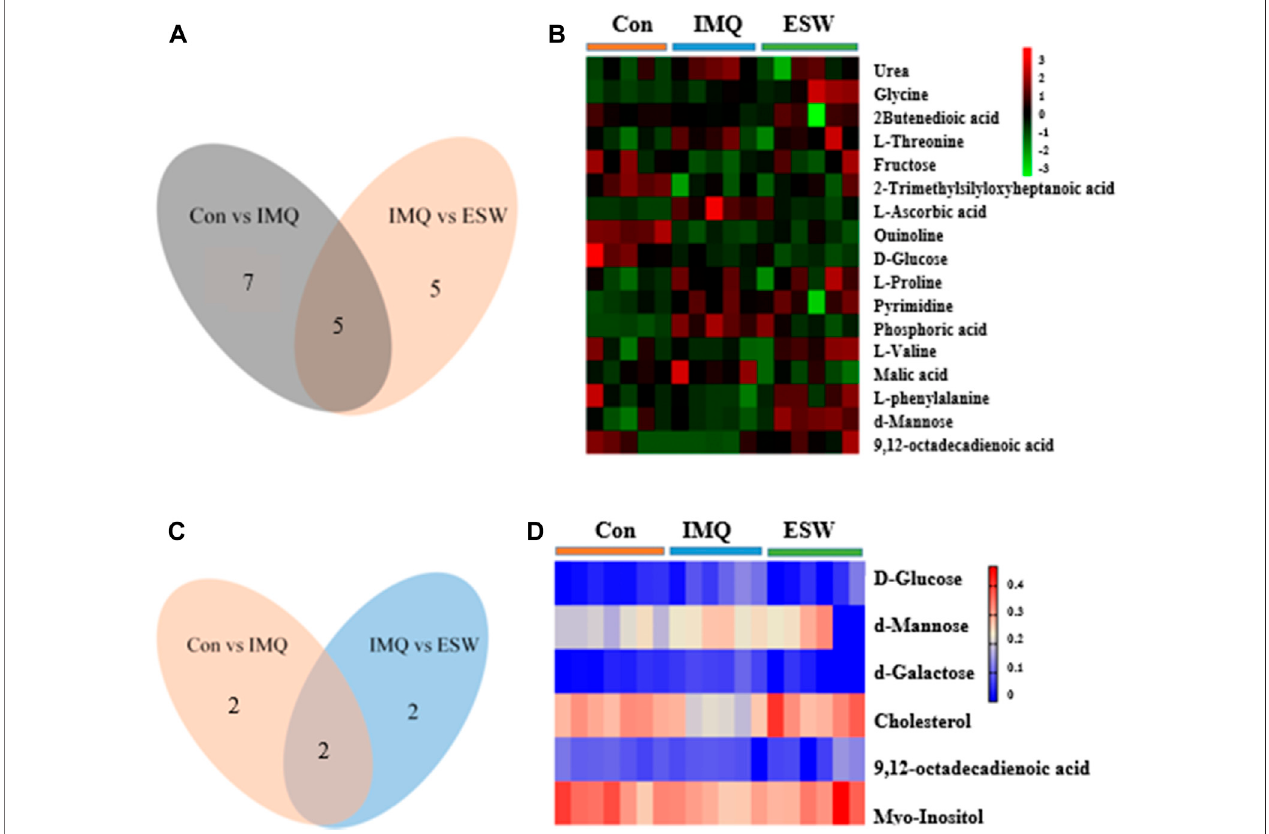
FIGURE 8 | Venn diagram of the signi fi cant differential metabolites and heatmap of differential metabolites in the spleen (A , B) and serum (C , D) .